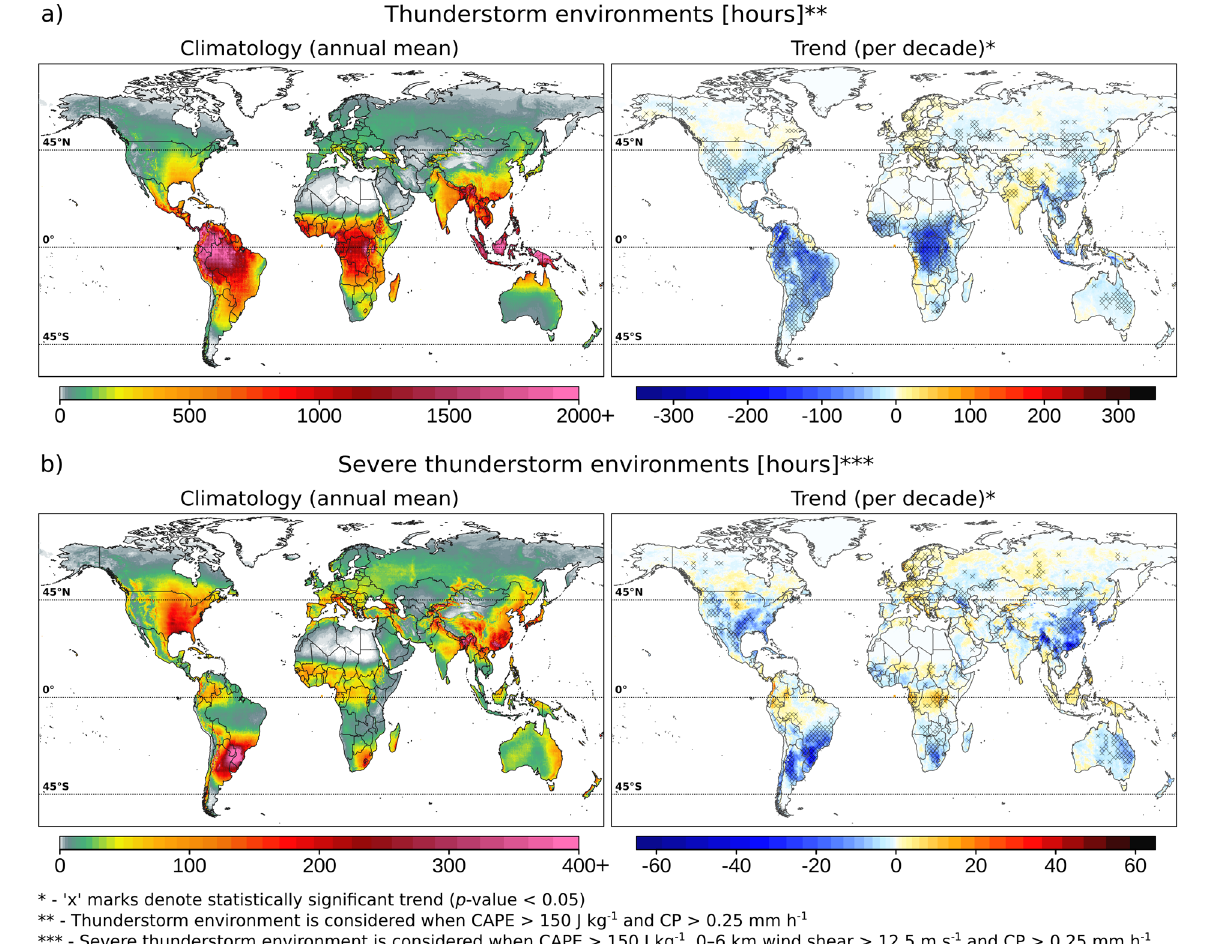
Fig. 2 ERA5 climatology and trends for thunderstorm and severe thunderstorm environments. As in Fig. 1 but with the application of a land-surface mask and showing the combined frequency proxy of ( a ) thunderstorm environments, and ( b ) severe thunderstorm